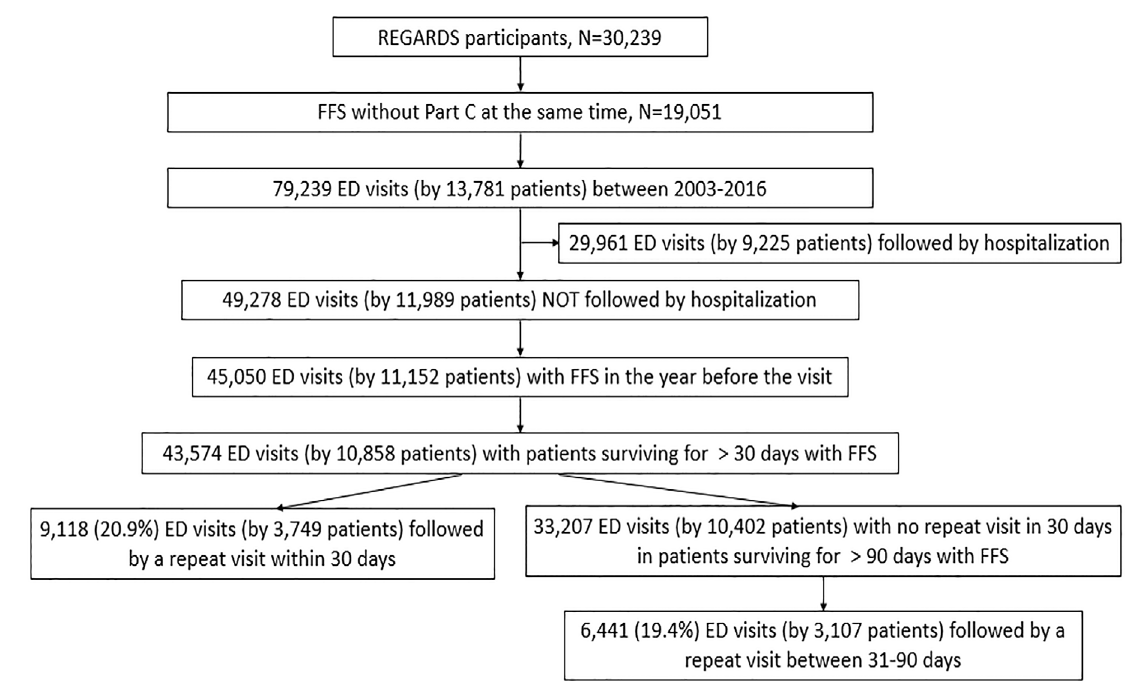
Figure 1. REGARDS participants between 2003-2016 included in analysis.